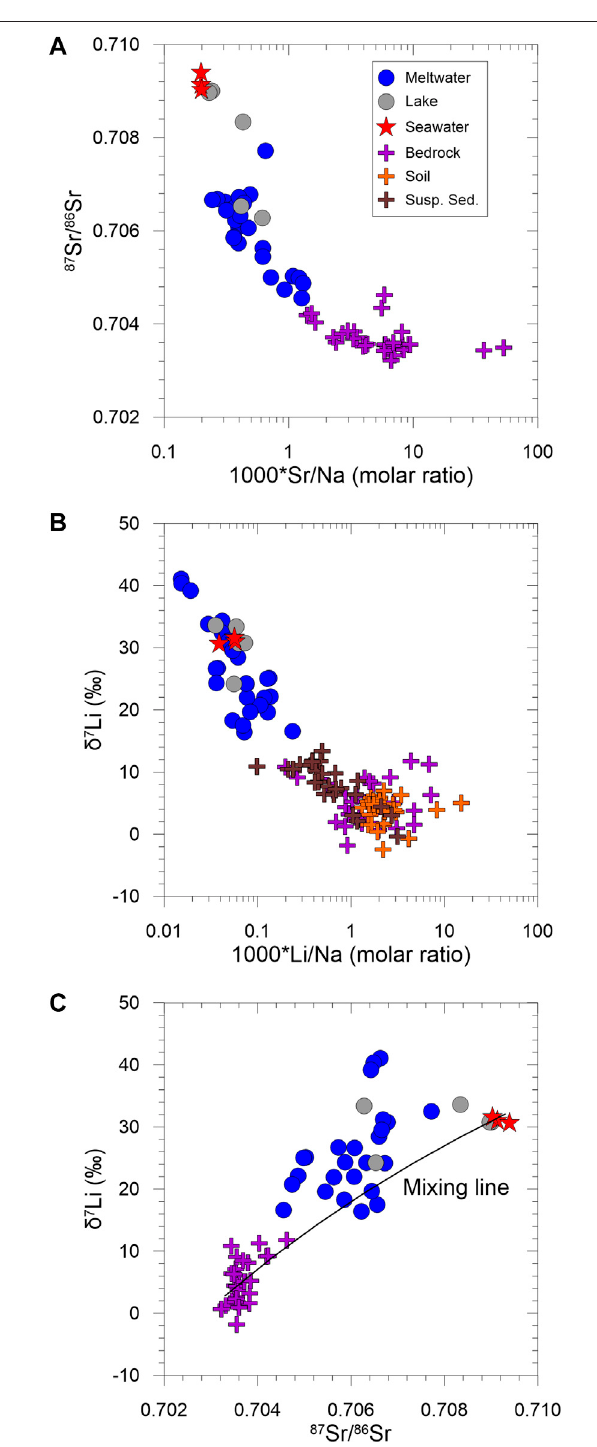
FIGURE 5 | Plots of 87 Sr/ 86 Sr ratios versus Sr/Na (molar ratio) (A) , δ 7 Li versus Li/Na (molar ratio) (B) and δ 7 Li versus 87 Sr/ 86 Sr ratios (C) . Bedrock 87 Sr/ 86 Sr ratios are from Shin et al. (2009).